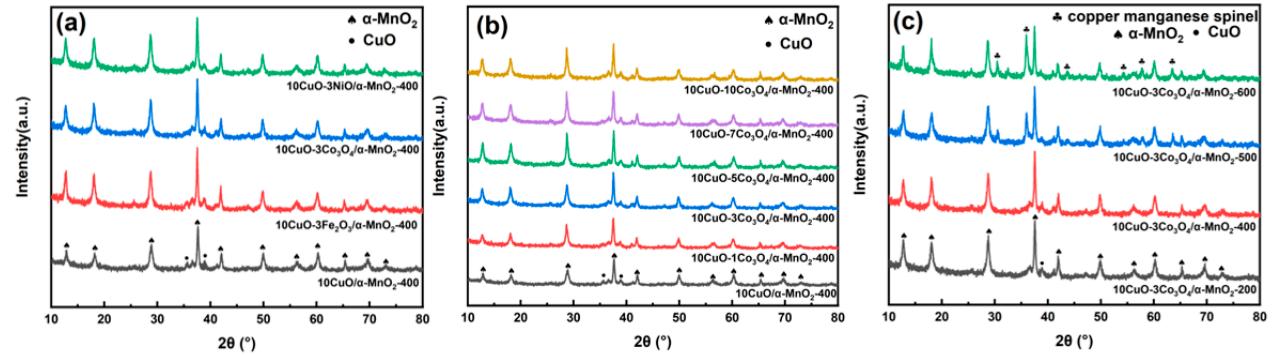
Figure 1. Powder XRD patterns of the ( a ) 10CuO-3MOx/ α -MnO 2 -400 catalysts doped with different transition metals (MOx = Fe 2 O 3 , Co 3 O 4 , NiO); ( b ) 10CuO-yCo 3 O 4 / α -MnO 2 -400 catalysts doped with different contents of Co 3 O 4 (y = 1, 3, 5, 7, 10); ( c ) 10CuO-3Co 3 O 4 / α -MnO 2 -T catalysts calcined at different temperatures (T = 200, 400, 500, 600 °C).